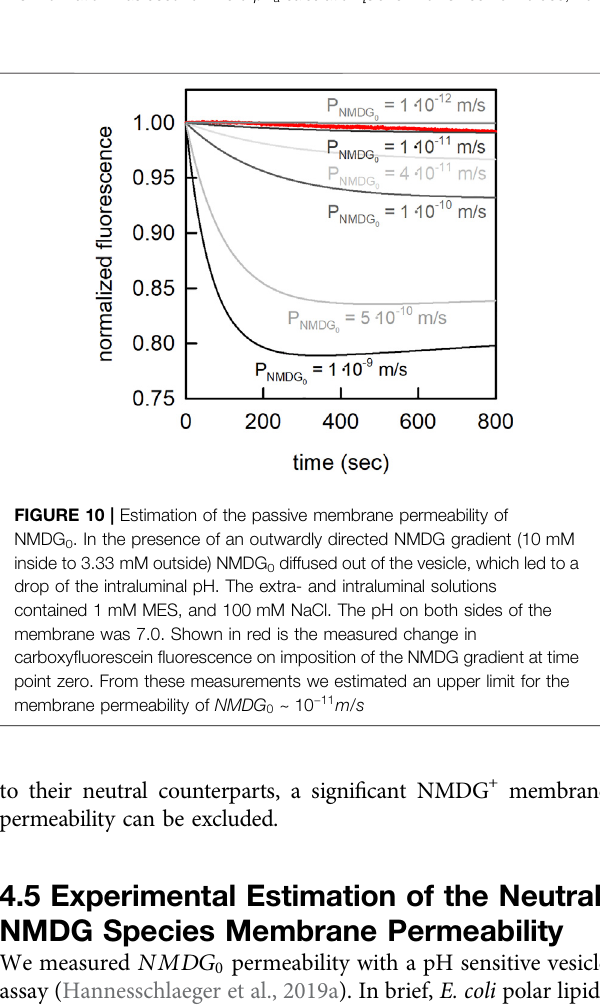
Frontiers in Physiology |